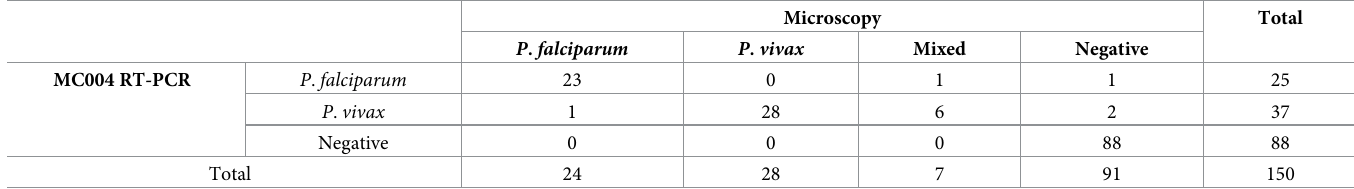
Table 3. Identification of Plasmodium species by using microscopy and RT